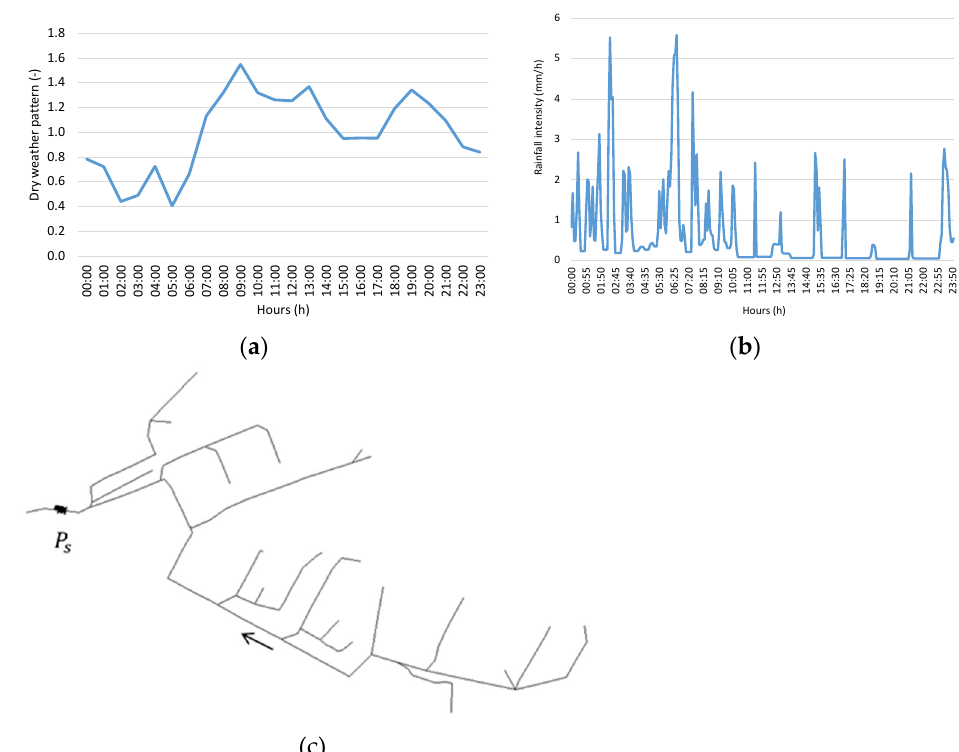
Figure 3. Venteira case study: ( a ) daily dry weather pattern, ( b ) rainfall event, and ( c ) network scheme.